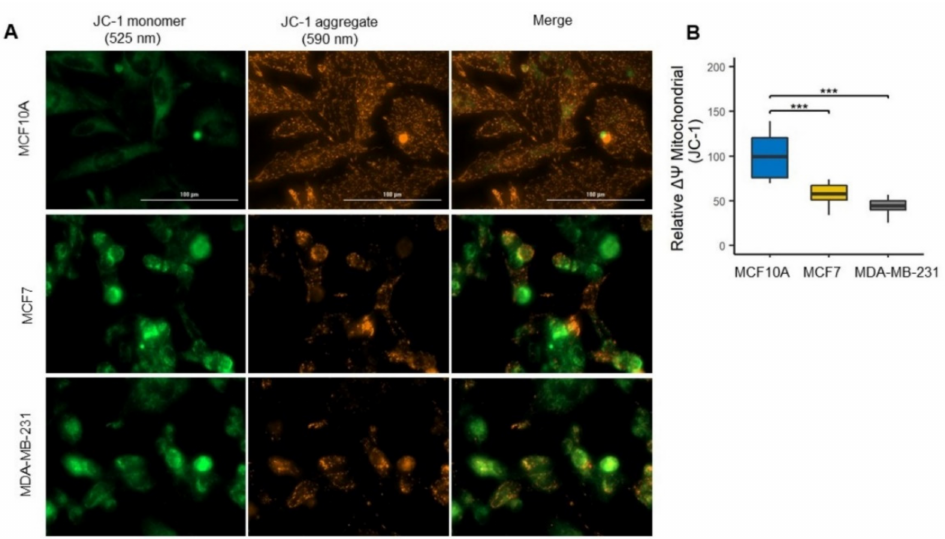
Figure 4. Decrease in mitochondrial membrane potential ( ∆Ψ m) in the MDA-MB-231 cell line. ( A ) ∆Ψ m levels were assessed by JC-1 probe; MCF10A cells with highly polarized mitochondria accumulate JC-1 dye in the mitochondrial matrix, forming bright red fluorescent J aggregates. In- creased green fluorescence indicates decreased mitochondrial potential. ( B ) The JC-1 fluorescence was quantified as the red fluorescence/green fluorescence ratio in MCF10A ( n = 7), MCF7 ( n = 12), and MDA-MB-231 ( n = 11) cell lines. Data were obtained from three biological replicates. The data were normalized with the values of MCF10A cells and are presented as mean ± SD. *** p <